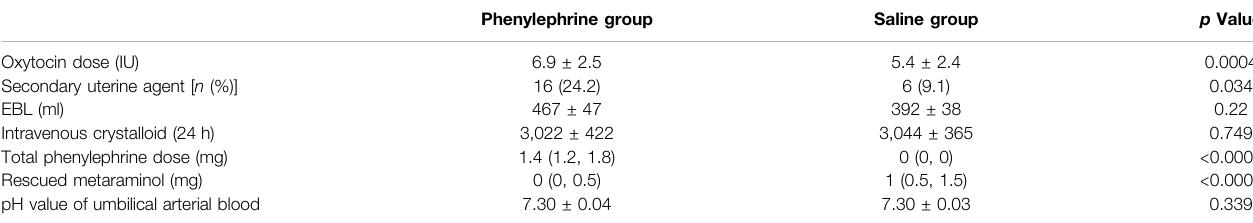
TABLE 2 | Comparison of oxytocin, secondary uterine agent, EBL, phenylephrine and rescued metaraminol dose and pH value of umbilical arterial blood.